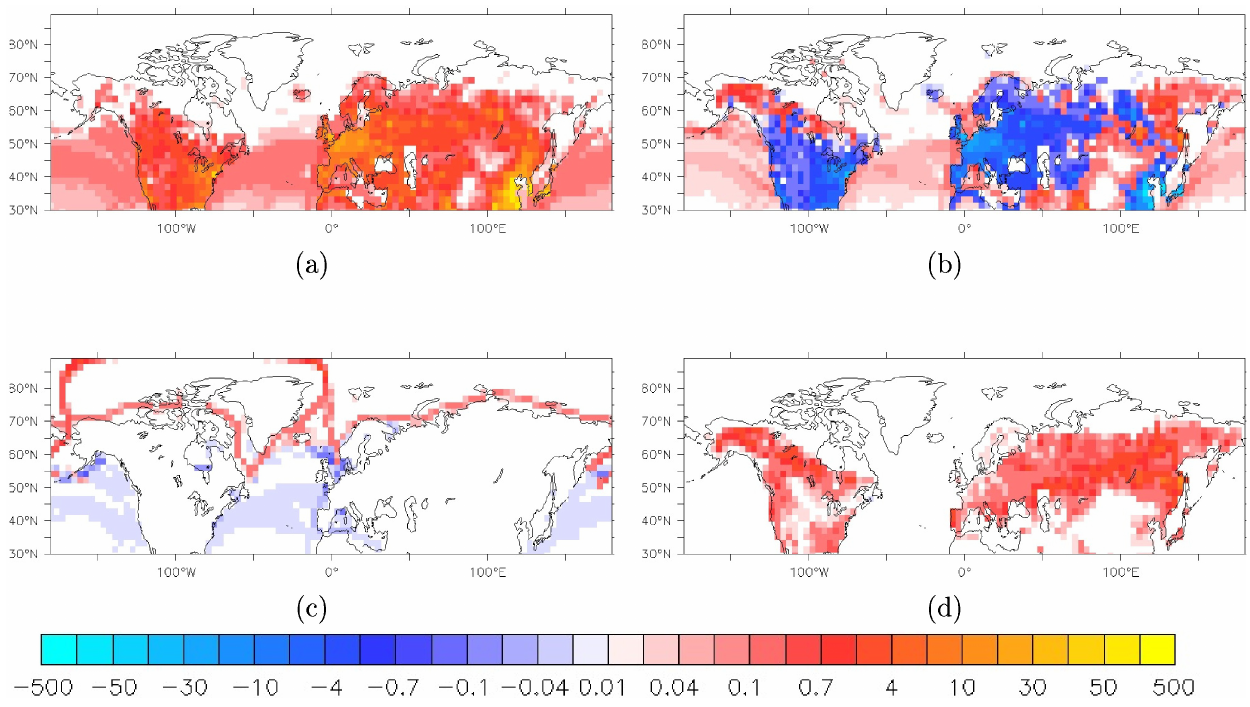
Fig. 1. Annual mean of BC emissions (mgm − 2 month − 1 ) ; (a) current emissions (S1, total = 2878Ggyr − 1 ); (b) difference between 2050 RCP8.5 scenario and current emissions (S2–S1; difference =− 1588Ggyr − 1 ); (c) difference in 2050 ships emissions in a scenario with a large ship traffic over the Arctic region (Corbett et al., 2010) with the 2050 RCP8.5 projected ship traffic scenario (S3–S2, differ- ence =+ 3.9Ggyr − 1 ); (d) difference in 2050 fire emission between a scenario with lengthened biomass burning season (constructed after Flanningan et al., 2009a, b) and the 2050 RCP8.5 scenario projected fire emissions (S4–S2, difference =+ 235.9Ggyr − 1